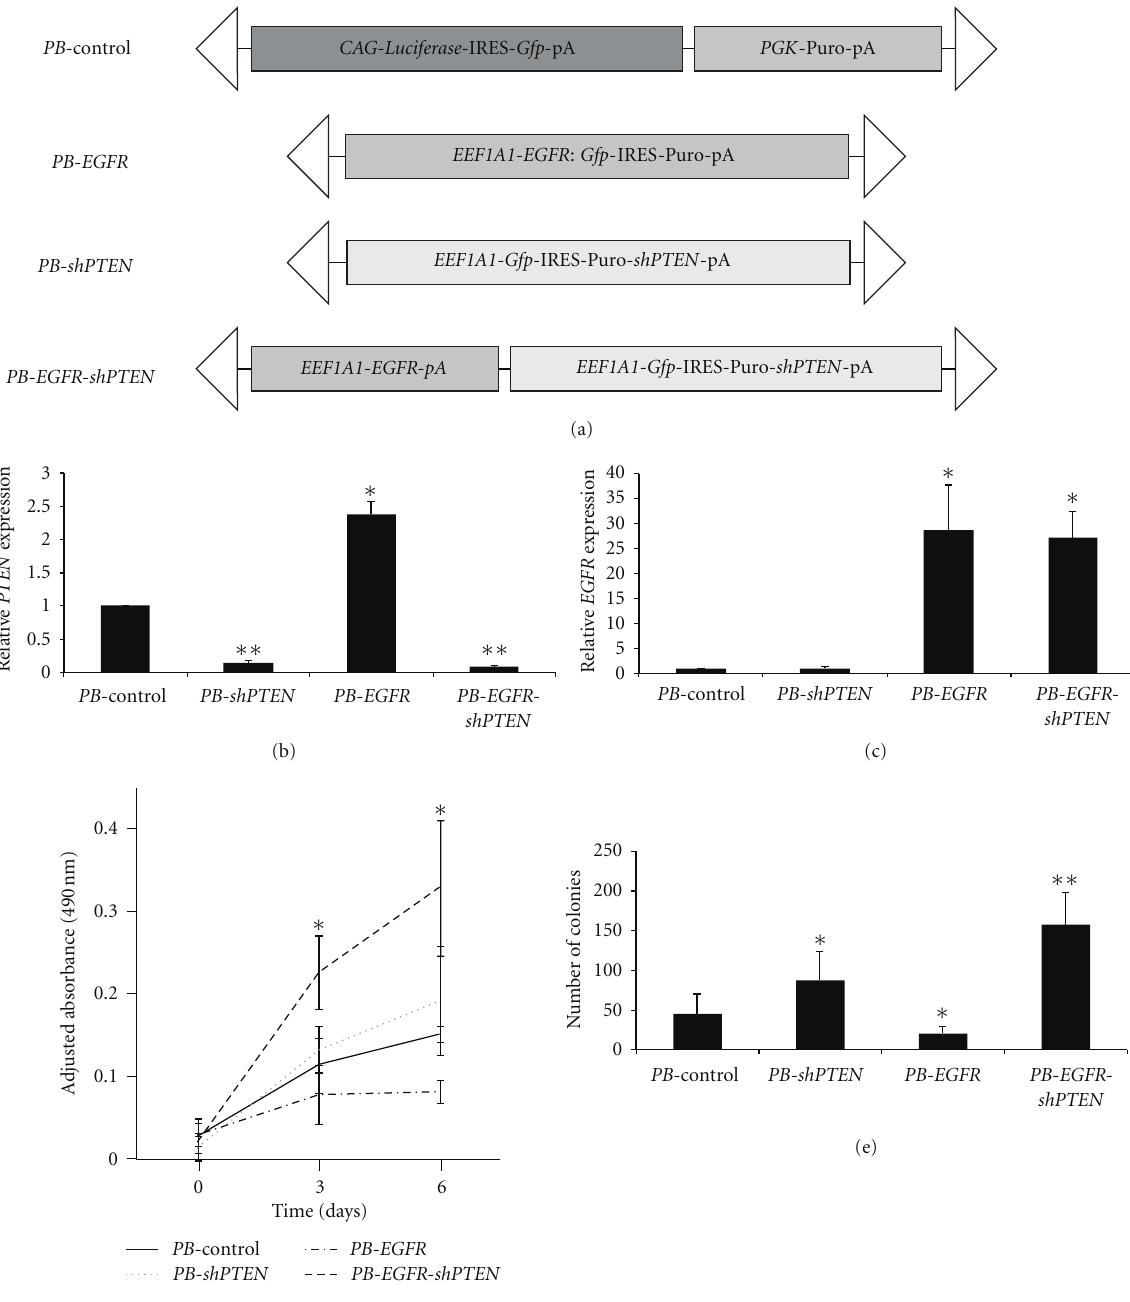
Figure 5: Knockdown of PTEN and overexpression of EGFR cooperate in vitro to oncogenically transform immortalized human Schwann cells. (a) PiggyBac ( PB ) constructs used to knock down PTEN ( PB - shPTEN ) and/or overexpress EGFR ( PB - EGFR ) in HSC2 λ immortalized human Schwann cells . CAG : cytomegalovirus early enhancer element and chicken beta-actin promoter; PGK : phosphoglycerate kinase ; EEF1A1 : eukaryotic translation elongation factor 1 alpha 1 promoter; IRES: internal ribosome entry site; Gfp : green fluorescent protein ; pA: polyadenylation signal; Puro: puromycin resistance gene; triangles: PB -specific inverted terminal repeat sequences. Quantitative PCR analysis demonstrating that PTEN mRNA levels are reduced (b) and EGFR mRNA levels are increased (c) when these constructs are stably transfected into HSC2 λ cells. (d) MTS proliferation assay shows that PTEN knockdown or EGFR overexpression alone do not change the rate of proliferation compared to control transfected cells, but when combined significantly increase cellular proliferation. (e) Soft agar colony formation assay demonstrates that PTEN knockdown moderately increases colony formation, but in the context of EGFR overexpression, reduction in PTEN significantly increases the number of colonies formed. ∗ P < 0 . 05 and ∗∗ P < 0 . 0001, unpaired t -test; mean ± standard